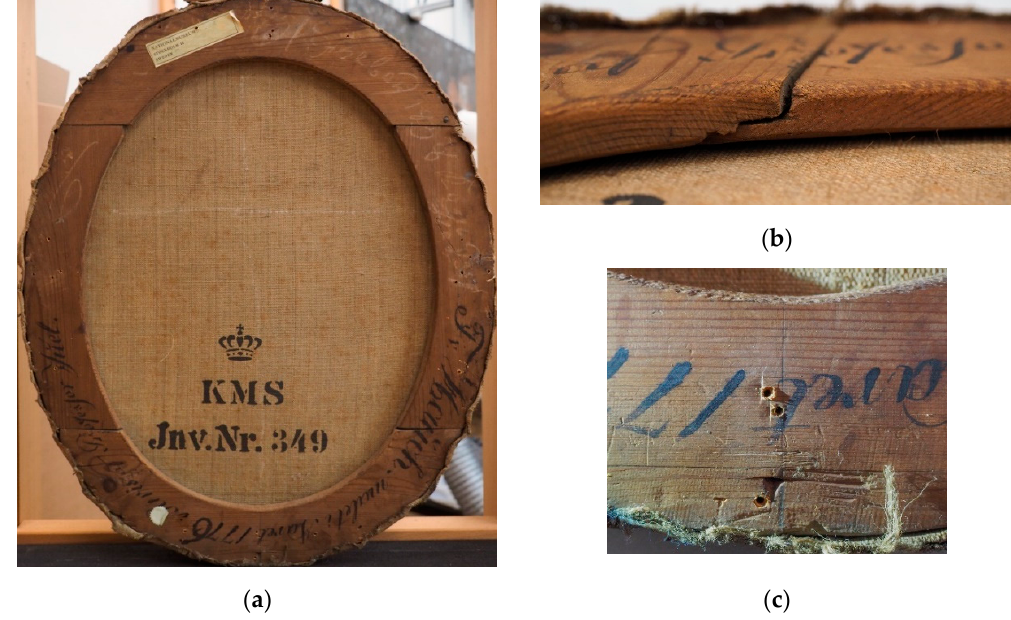
Figure 4. The verso of F. Hauch (KMS349): ( a ) displaying the likely original French strainer with inscription “ F.v. Hauch Malet i Aaret 1776 i Paris af Professor Juel ” (F.v. Hauch painted in 1776 in Paris